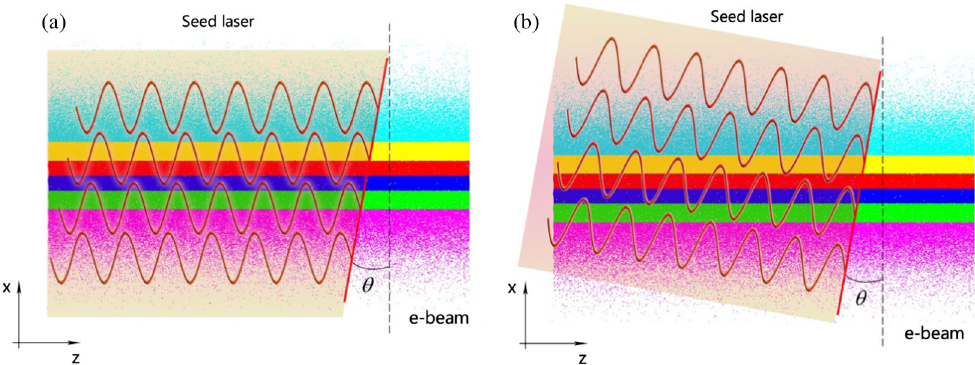
FIG. 1. Schematic of two methods for three-dimensional manipulations of the electron beam phase space with a transversely dispersed electron beam ( x - z ) and a wave front tilted seed laser: (a) directly tilt the wave front of the seed laser, and (b) oblique incidence the seed laser with a small angle θ